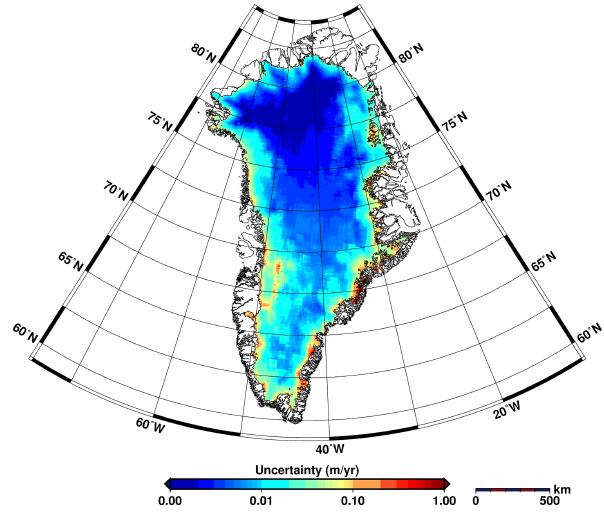
Figure A4. Uncertainty map of elevation change of Greenland de- rived from error propagation. Clearly indicated are the high uncer- tainties at the steep margins. Table A3. Assumed uncertainty contribution to a single Range mea- surement. The speckle is estimated by Wingham et al. (2006) to be 0.16m and the geophysical corrections, including the ionosphere and the dry and wet troposphere, are in total within 0.04m over the ice sheets (E. Schrama, personal communication,